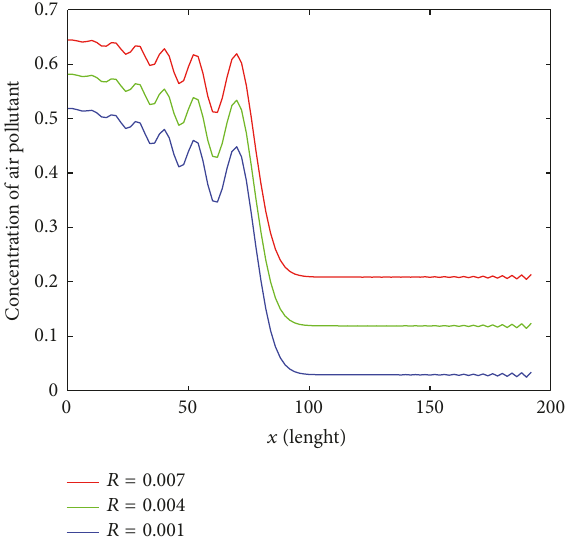
Figure 11: Compare the concentration of air pollutant where 𝑅 = −0.001, 𝑅 = −0.004 , and 𝑅 = −0.007 sec −1